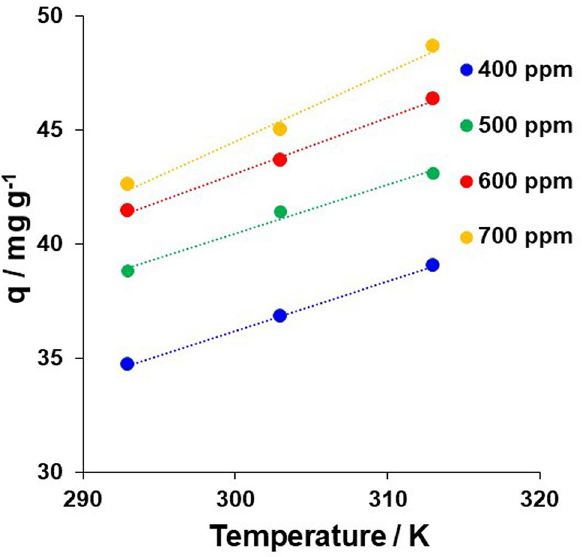
Figure 6. Effect of temperature on Pd(II) sorption by 1 -EIR at various Pd(II) concentrations. Sorption conditions: 1 -EIR = 0.1 g, [HCl] = 0.1 M; [Pd(II)] = 400–700 ppm (= mg L −1 ); temperature = 293–313 K; shaking time = 24 h; shaking speed = 80 rpm.